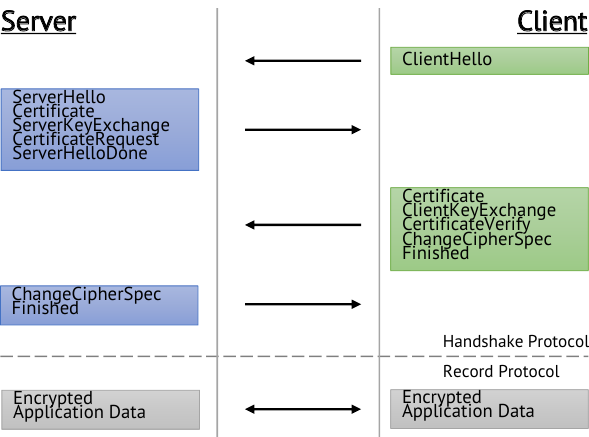
Figure 1. Procedure of the TLS 1.2 handshake as defined in [12].